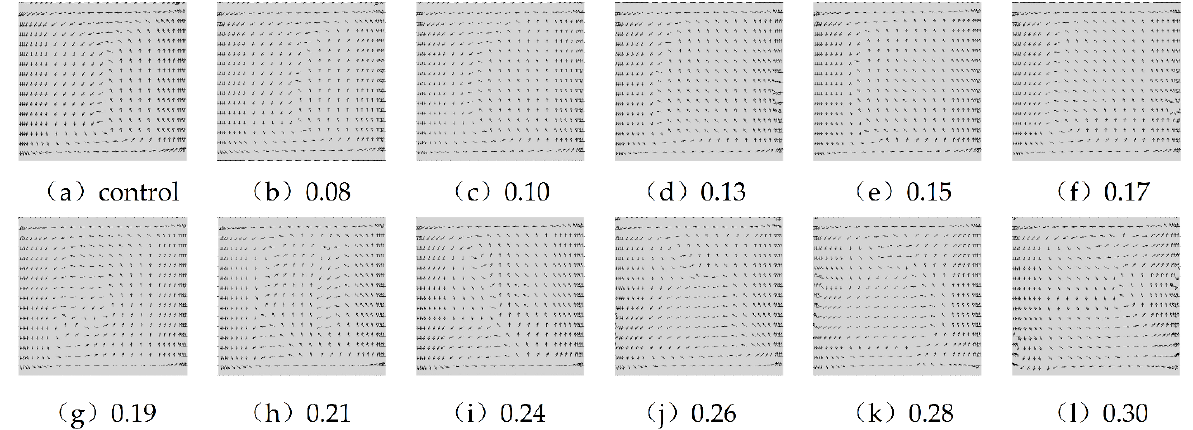
Figure 5. Velocity vector distribution in the flume at different speed ratios.